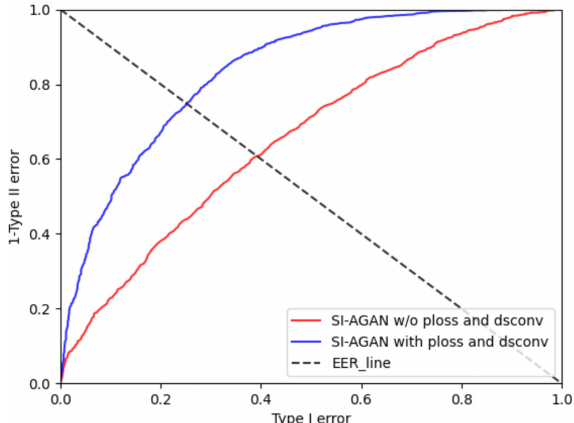
Figure 18. ROC curves of gender recognition accuracies with SI-AGAN with or without perceptual loss and depthwise separable convolution. (w/o refers to without, ploss refers to perceptual loss, dsconv refers to depthwise separable convolution).